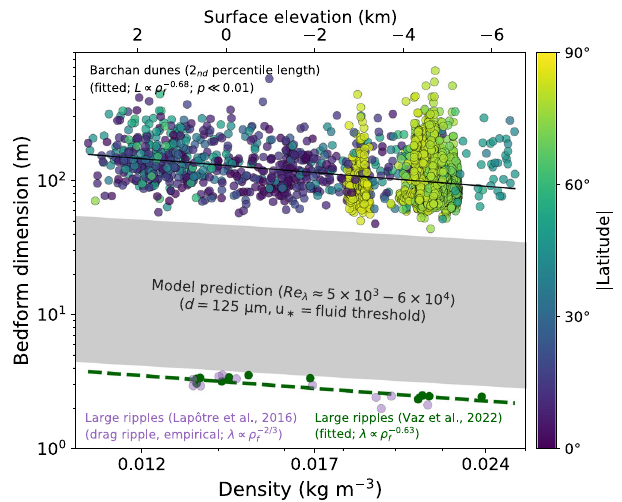
Fig. 3 | Dune length (blue-to-yellow circles) and large-ripple wavelength (light purple 1 and dark green circles 36 ) decreases with increasing atmospheric den- sity. Rippledatafollowsapreviouslyderivedscalingrelationshipsfordragripples 5 ; best- fi t power law to an updated global compilation of dark-toned large-ripple wavelength has an exponent of − 0.63 (green dashed line) 35 . The width of the hydrodynamic anomaly (gray shade) was calculated for a 125 μ m grain size 7 and assuming that wind shear velocity is at the transport threshold 49 (Methods), using the model of ref. 12. The statistical signi fi cance of the regression slope was com- puted using a Wald Test, and errorbars (narrower than line width) indicate a 95% con fi dence interval. Each dot in the fi gure represents the 2nd percentile dune length in equal-area bins (60 km 2 ).